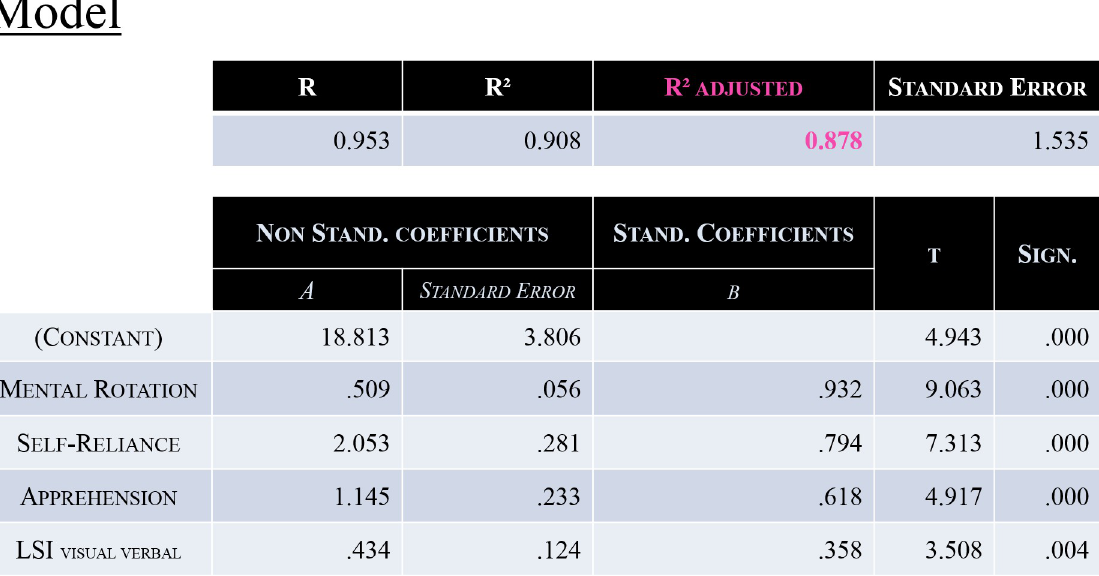
= 0.878, p < 0.001]. adj